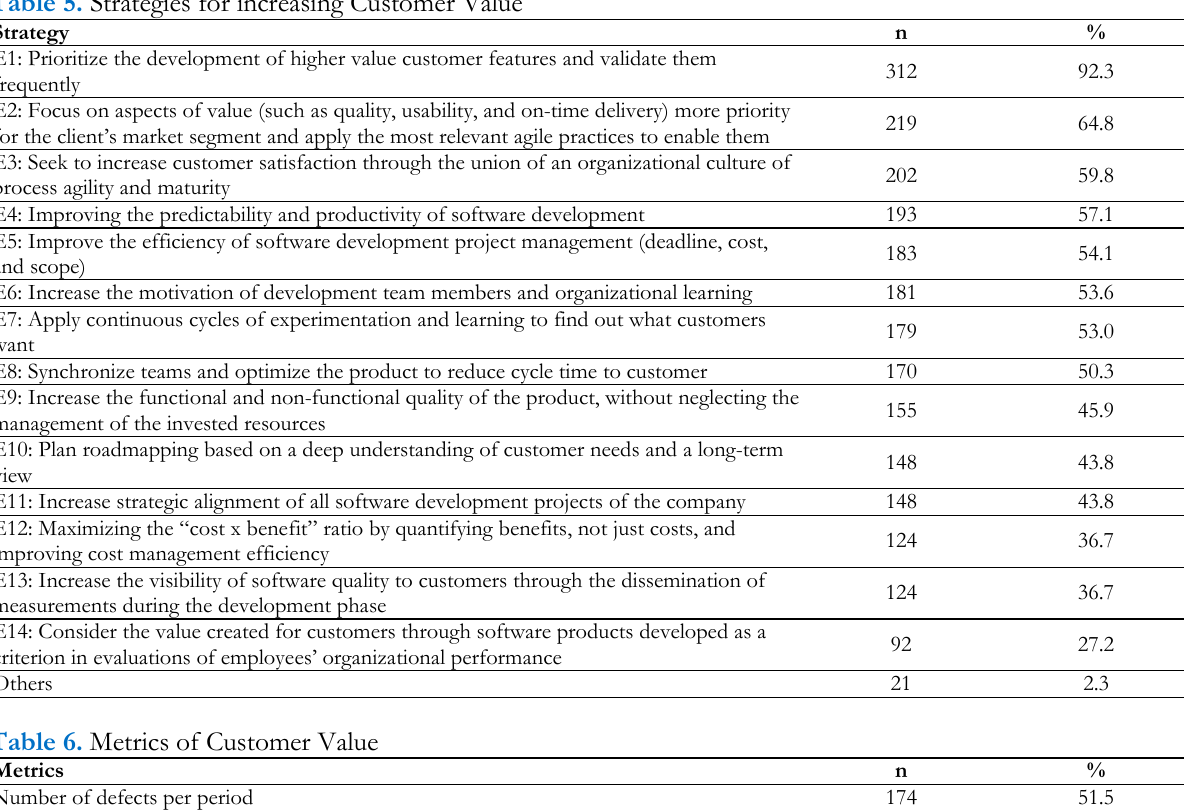
Table 5. Strategies for increasing Customer Value Strategy